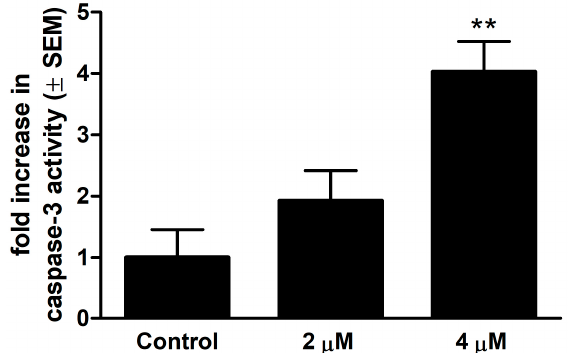
Figure 4. The proapoptotic property of the test compound was confirmed by assessing caspase-3 activity on SiHa cells at 24 h post-treatment. At a concentration of 4 µ M, 13AES3 induced a 3-fold increase in caspase-3 enzyme activity compared to untreated control cells. ** indicates significance at p < 0.01.